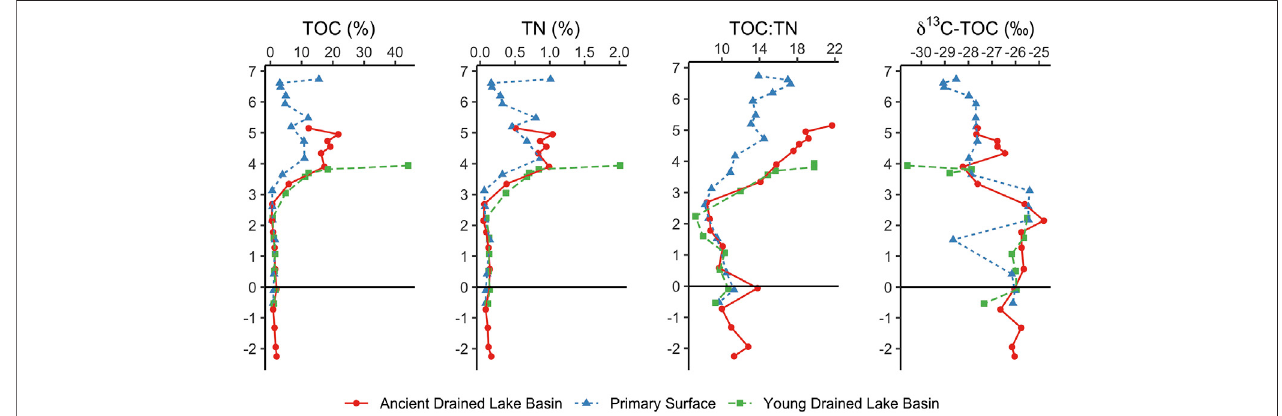
FIGURE5| Totalorganiccarbon(TOC;wt%),totalnitrogen(TN;wt%),organiccarbontonitrogenmolarratio(C:N),and δ 13 C-TOC( ‰ )pro fi lesforthreepermafrost cores. Colors and symbols indicate the geomorphic terrain unit each core was sampled from. The black horizontal lines indicate mean local sea level.